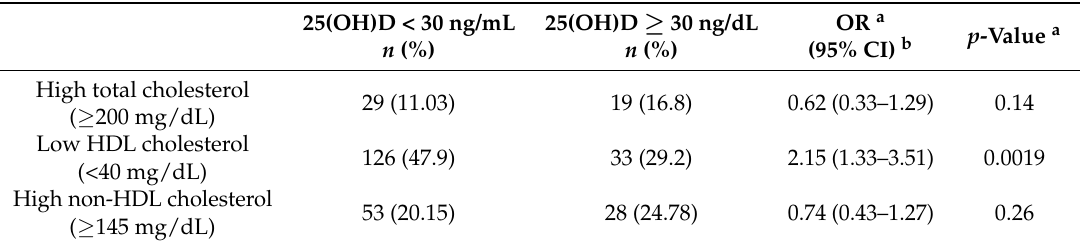
Table 3. Prevalence of abnormal lipids in patients with 25(OH)D < 30 ng/mL and in those with 25(OH)D levels ≥ 30 ng/mL.